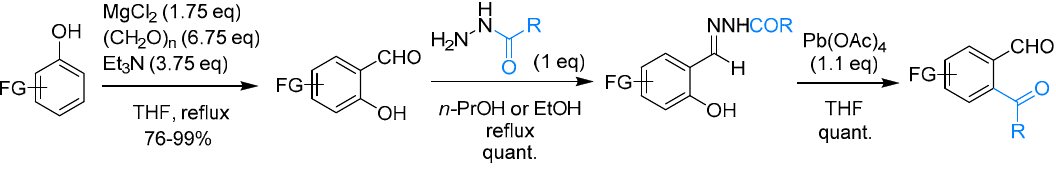
Scheme 40. Multi-step synthesis of o -ketobenzaldehydes.